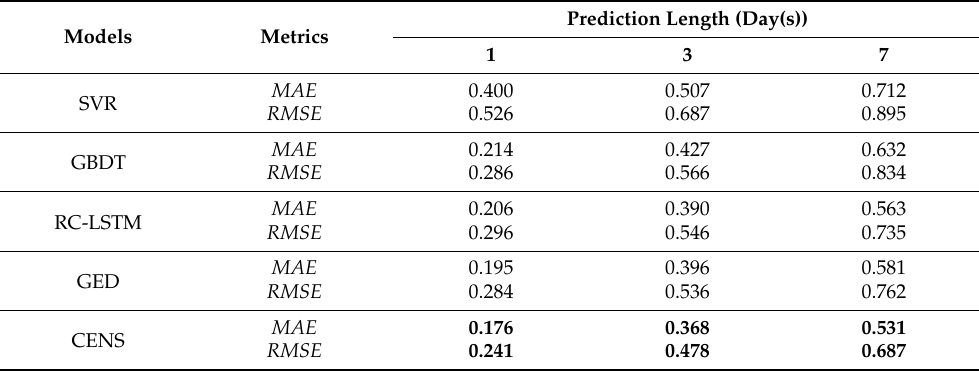
Table 2. Time series prediction results in the South China Sea.